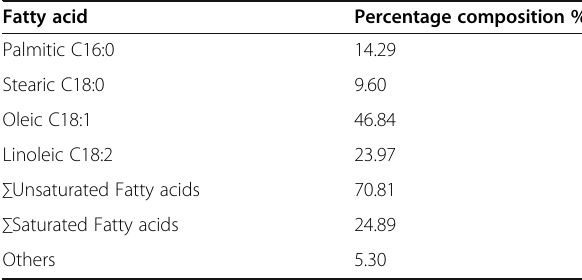
Table 2 Fatty acid profile of S. indicum oil